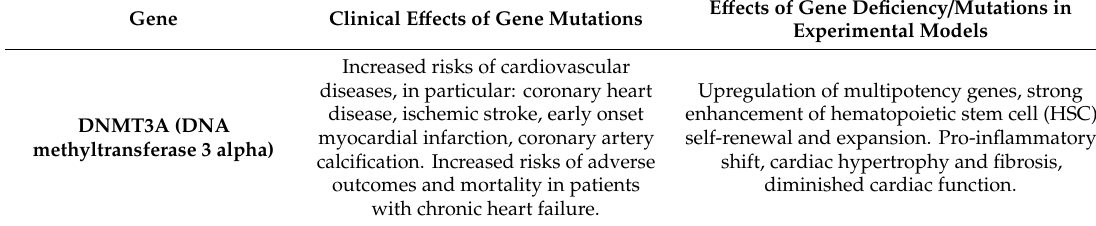
Table 1. Summary of clinical / epidemiological and experimental findings for genes with the most significant impact on clonal hematopoiesis and cardiovascular